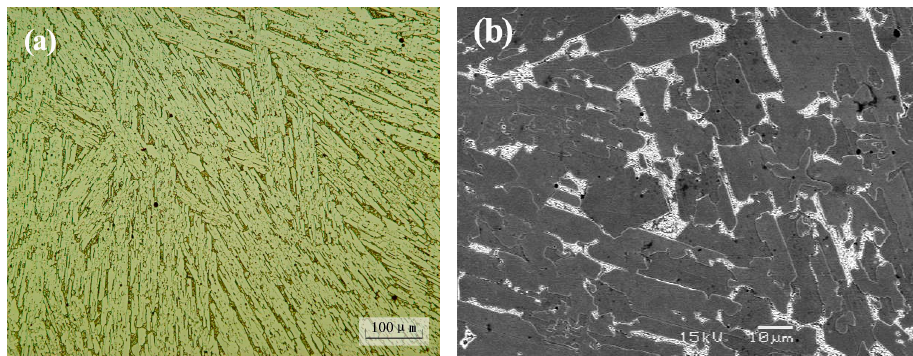
Figure 2. ( a ) Optical microscope (OM) and ( b ) scanning electron microscope (SEM) microscopy